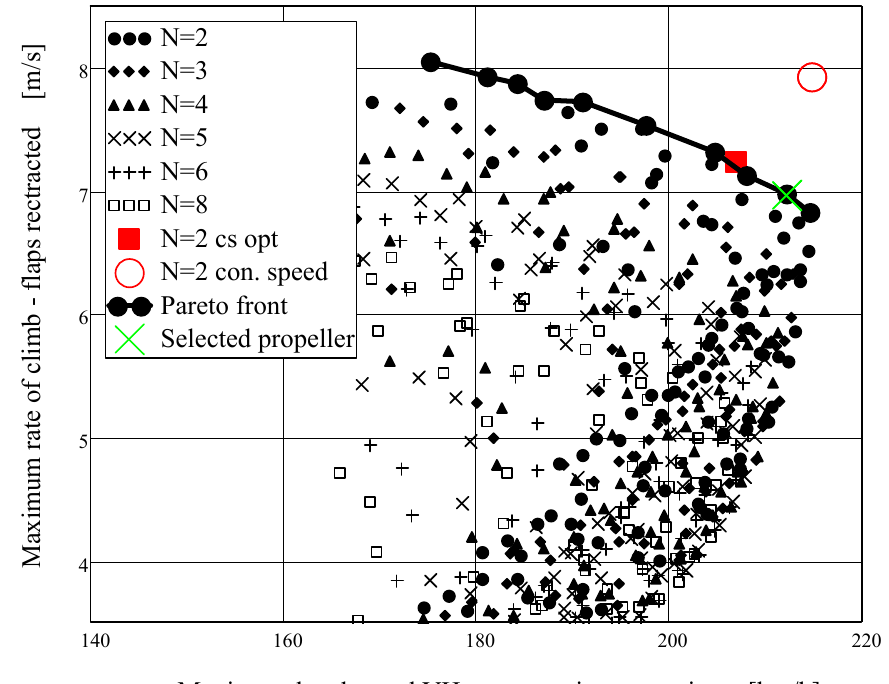
Figure 8. Pareto frontier for maximum horizontal flight speed (continuous engine regime) and maximum rate of climb (take-off engine regime). Table 3. Points on the Pareto front for maximum horizontal speed (continuous engine regime) and maximum rate of climb (take-off engine regime) (see Figure 8).